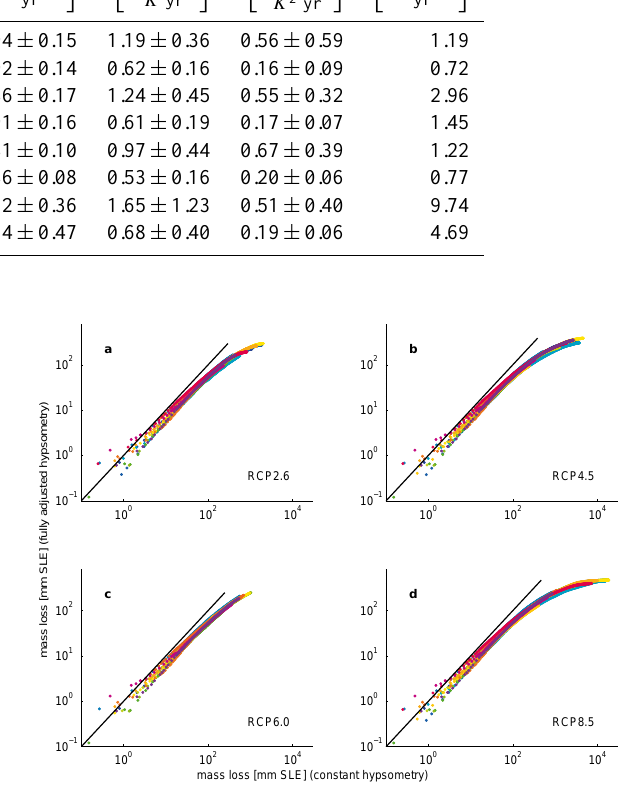
Fig. 7. Global glacier-mass loss when glacier hypsometry is held constant, and ice volume treated as infinite. Solid line is ensemble mean, dark/light shading indicates ensemble spread (one/two stan- dard deviations).